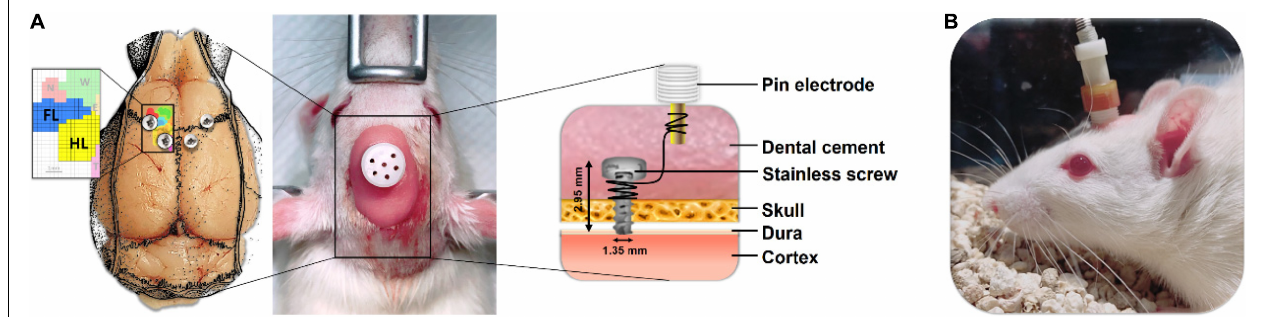
FIGURE 1 | Placement and assembly details of the cortical electrical stimulation (CES) electrodes for the long-term treatment of CES. (A) The CES electrodes were positioned at the motor cortex of the forelimb and hindlimb and connected to the six-channel pedestal with wires and fixed with dental cement. (B) During the CES treatment, the head electrode pedestal served as the plugin site of the electrode pin to conduct electrical